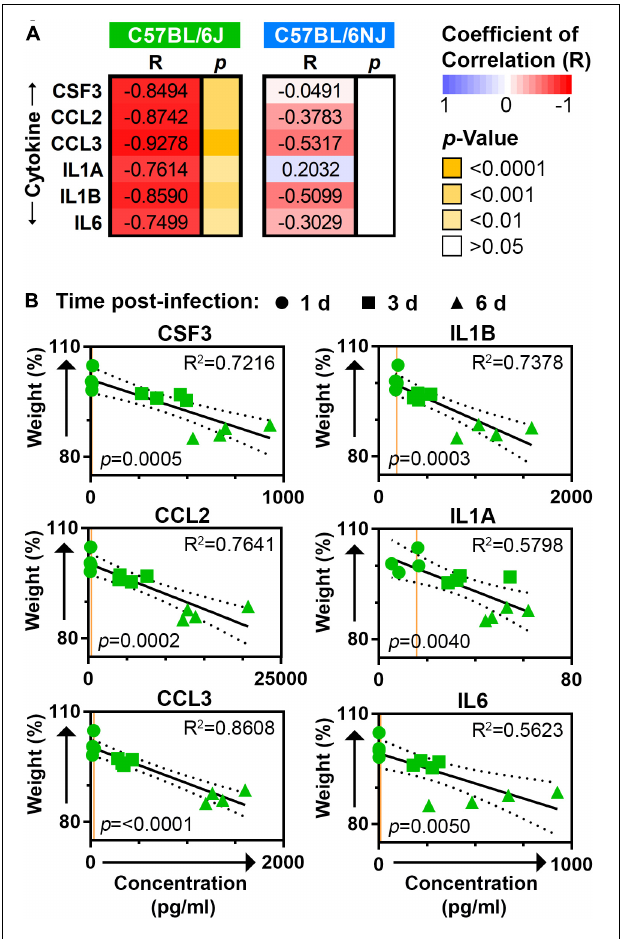
FIGURE 6 | Correlation between mouse body weights and lung cytokines. (A) The heat map shows Pearson coefficients of correlation ( R ) and corresponding p -values for body weights and lung cytokine measurements obtained from the CA04-infected C57BL/6J and C57BL/6NJ mice on days 1, 3, and 6 post-infection. (B) Scatter plots show matching body weight and lung cytokine measurements for C57BL/6J mice. In each plot, the time post-infection for each set of measurements is indicated by circles (day 1), squares (day 3), or triangles (day 6); the best fit linear regression is shown by a solid line with 95% confidence intervals indicated by dotted lines; coefficients of determination ( R 2 ) are given at the upper right; and p -values are given at the lower left. Orange lines represent the average expression in mock-infected samples for the given